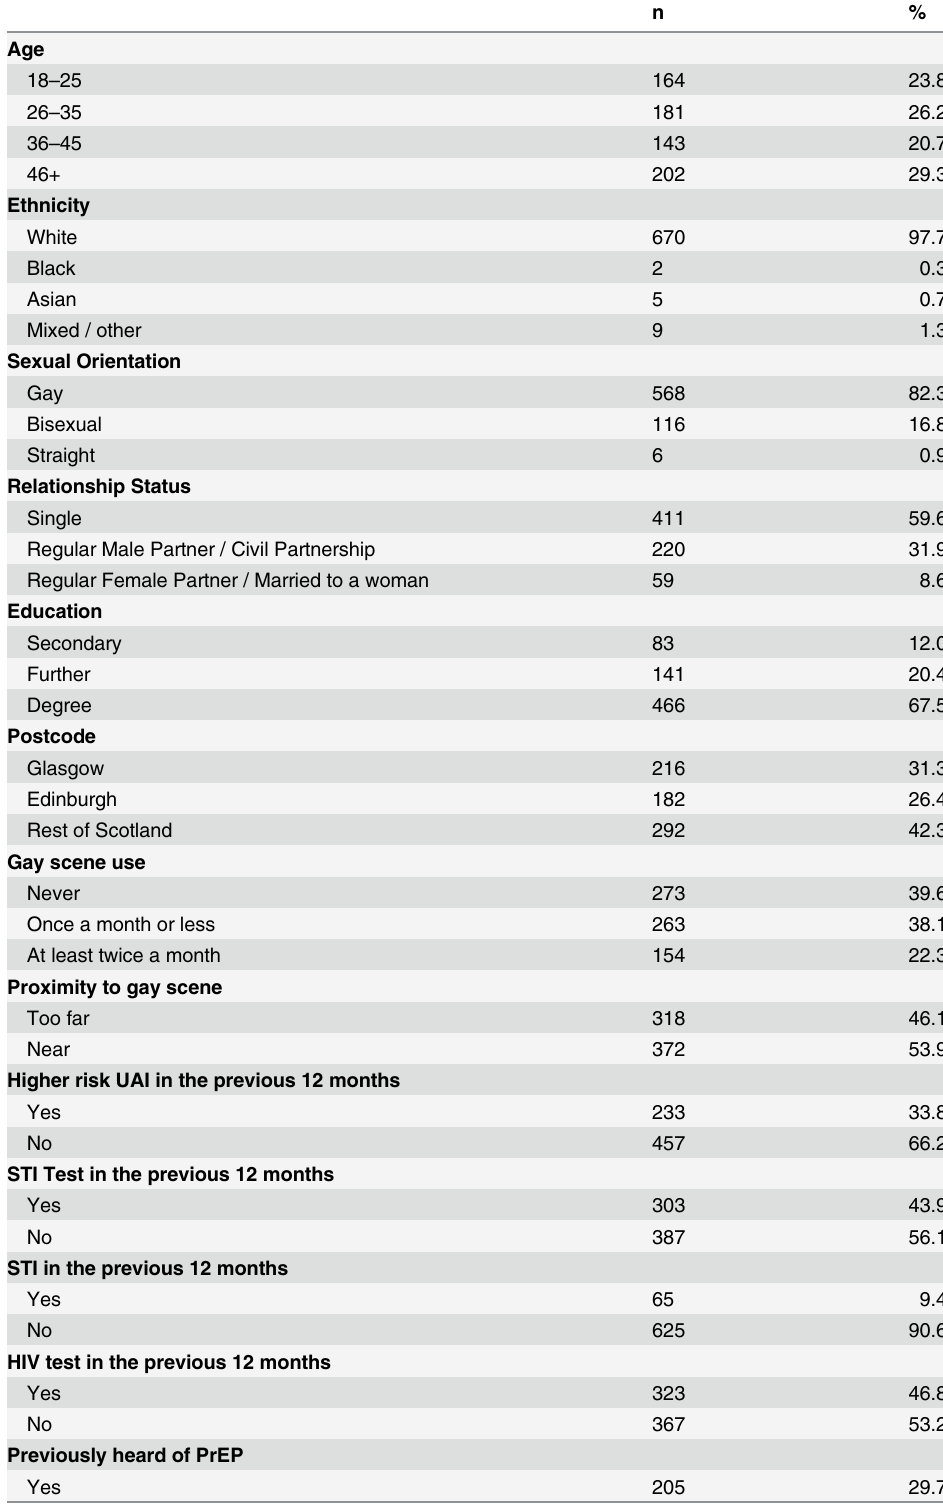
Table 1. Survey Sample Characteristics (N =